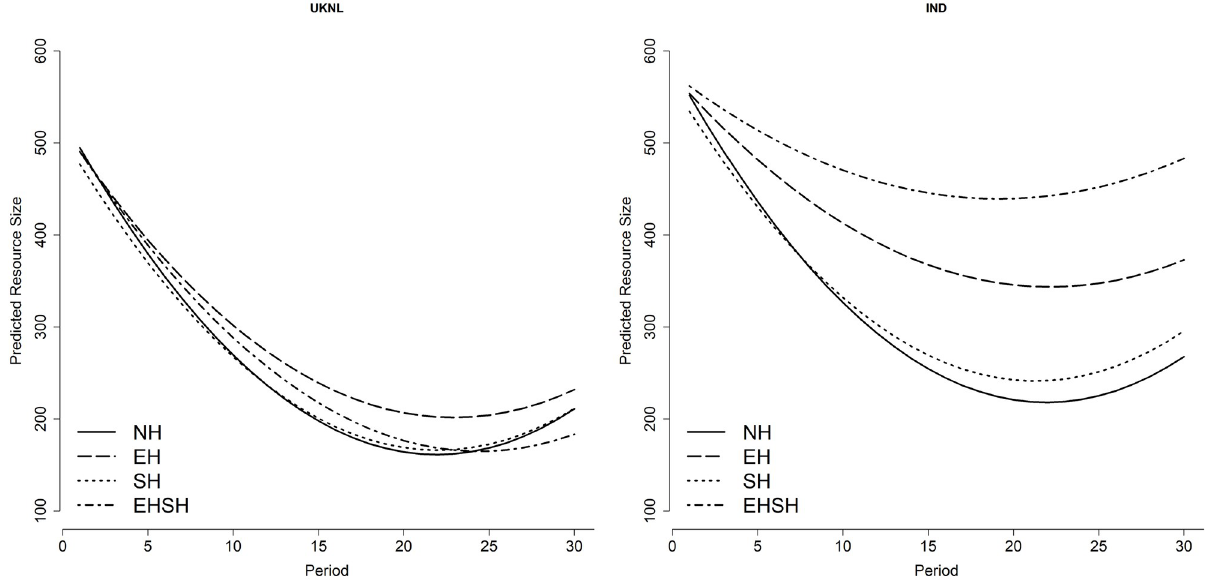
Fig 3. Predicted resource size per treatment per period.